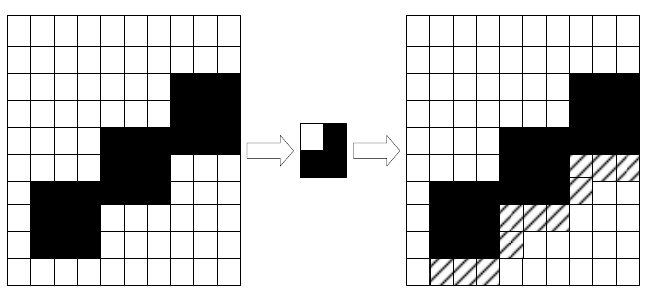
Figure 13. A diagram of the principle of expansion. In the figure, the black and white boxes represent black and white pixels, and the dot- ted boxes represent pixels that have been expanded and filled.